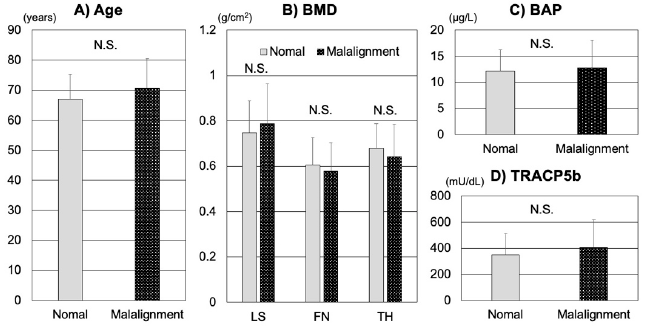
Figure 1. In patients without VFs, comparisons of ( A ) age, ( B ) BMD, ( C ) BAP, and ( D ) TRACP5b values determined in patients of the normal alignment and sagittal malalignment groups are shown. VF, vertebral fracture; N.S.: not significant; BMD, bone mineral density; BAP, bone-specific alkaline phosphatase; TRACP5b, tartrate-resistant acid phosphatase